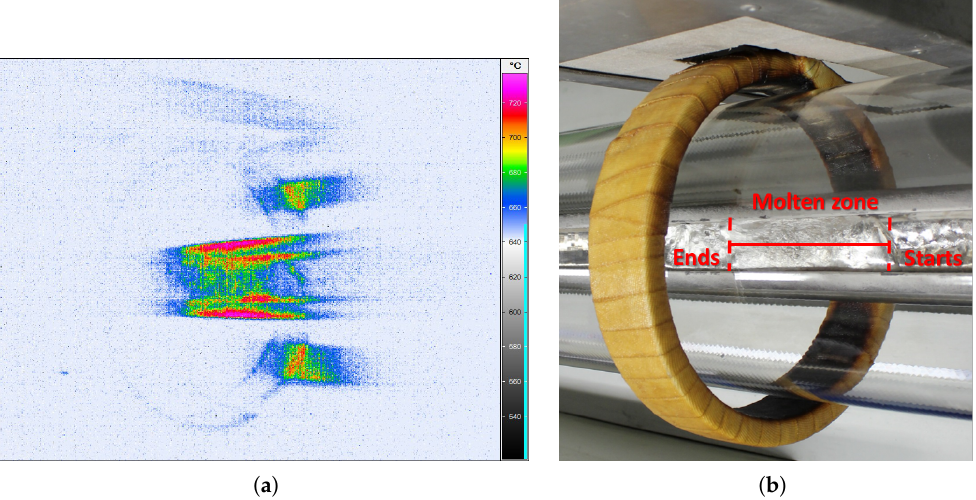
Figure 5. Comparison between the IR thermography ( a ) with the DSLR camera picture ( b ) showing the molten zone in the aluminum